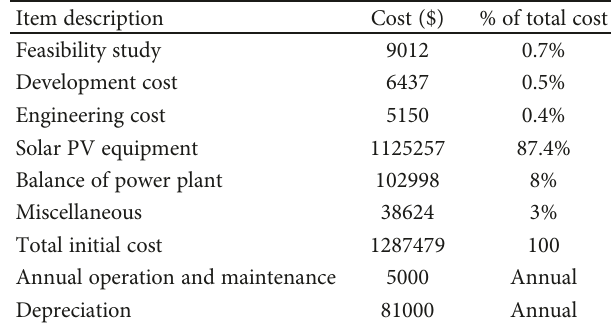
Table 6: Cost and economic assumption of the PV power plant [1]. Table 5: Assumption of various interest rates used in the economic